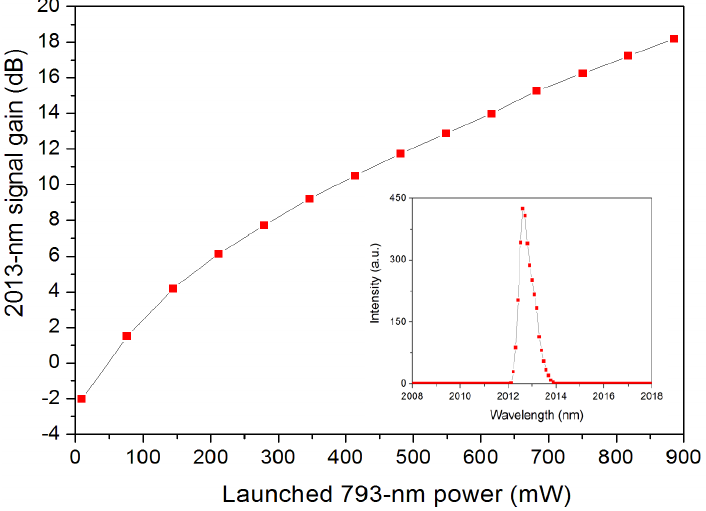
Figure 6. Experimental Tm 3+ -doped silicate fiber